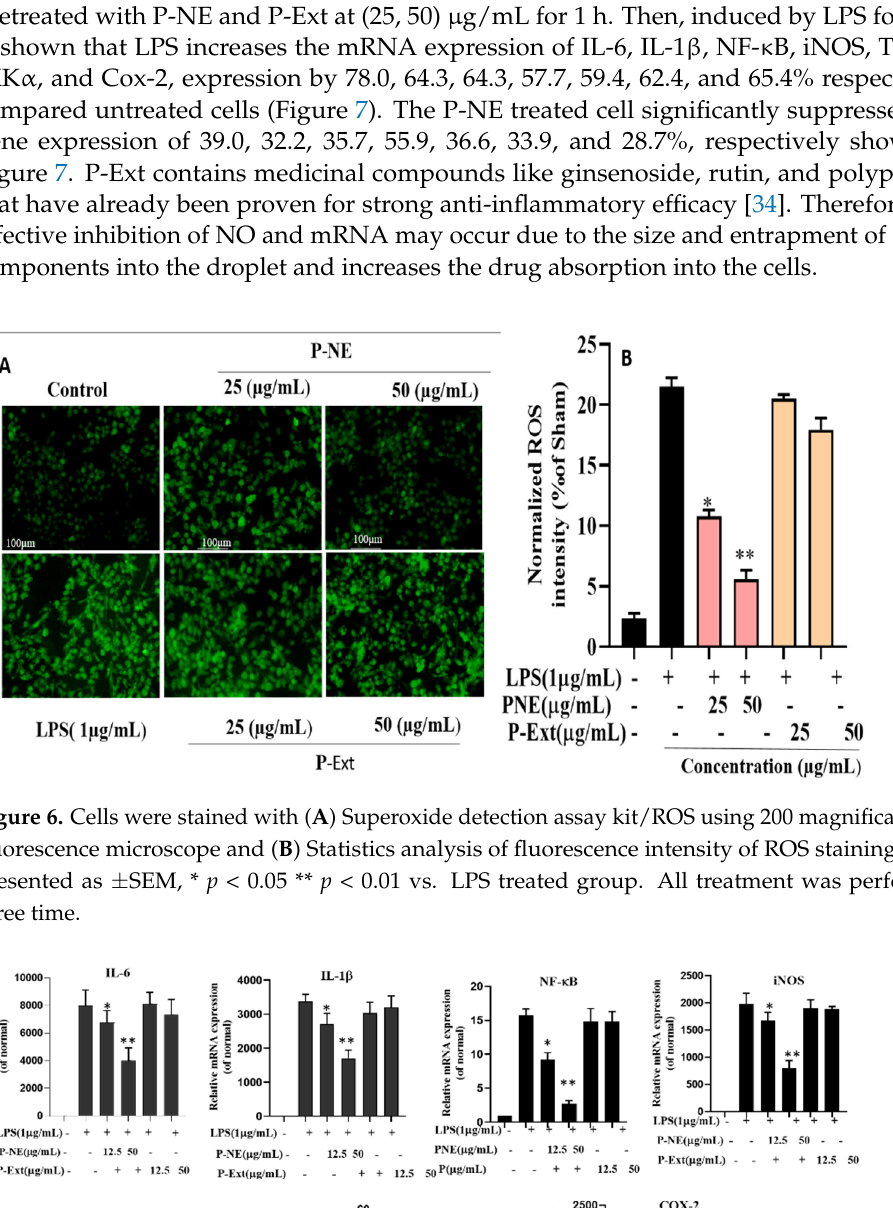
Figure 7. Effects of Panos nanoemulsion on pro-inflammatory mediators IL-6, IL-1 β , NF- κ B, iNOS, TNF- α , IKK α , and Cox-2 in LPS induced RAW 264.7 cells. The mRNA expression was determined by q-PCR analysis. Data presented as ± SEM, * p < 0.05 ** p < 0.01 vs. normal. All treatment was performed three